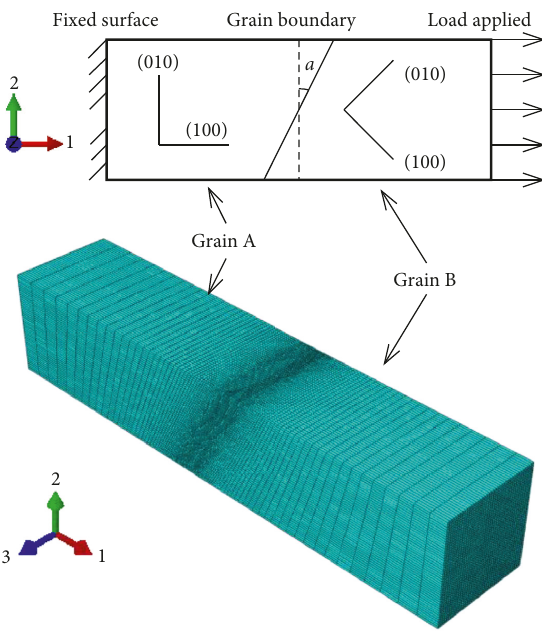
Figure 4: Type II GB inclination (0 ° < α ≤ 90 ° ).